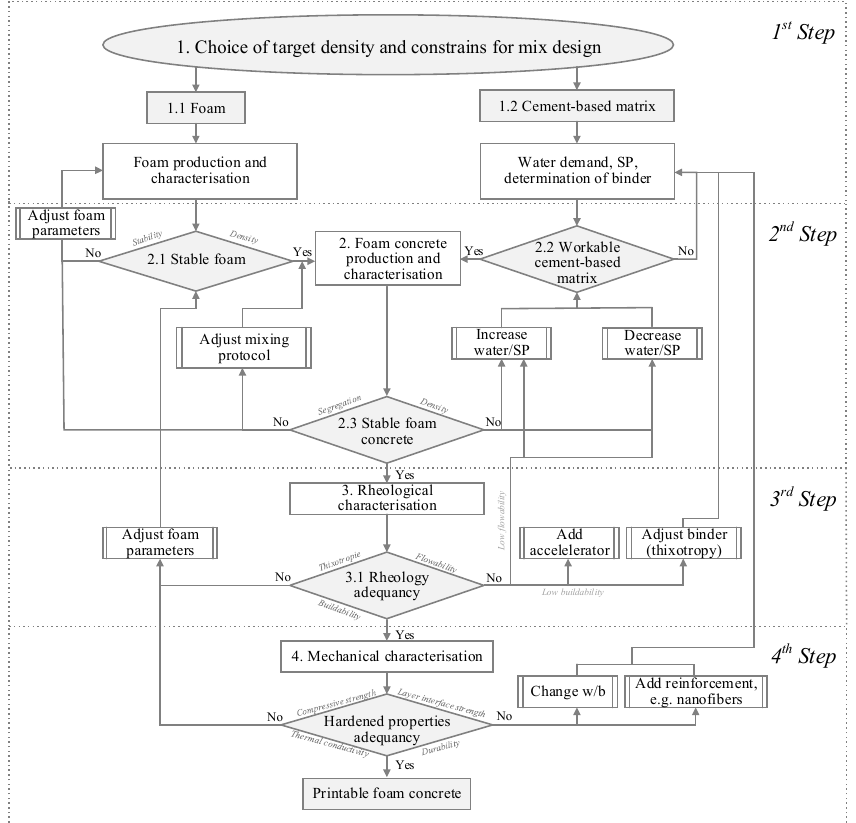
Figure 2. Mixture design approach for printable foam